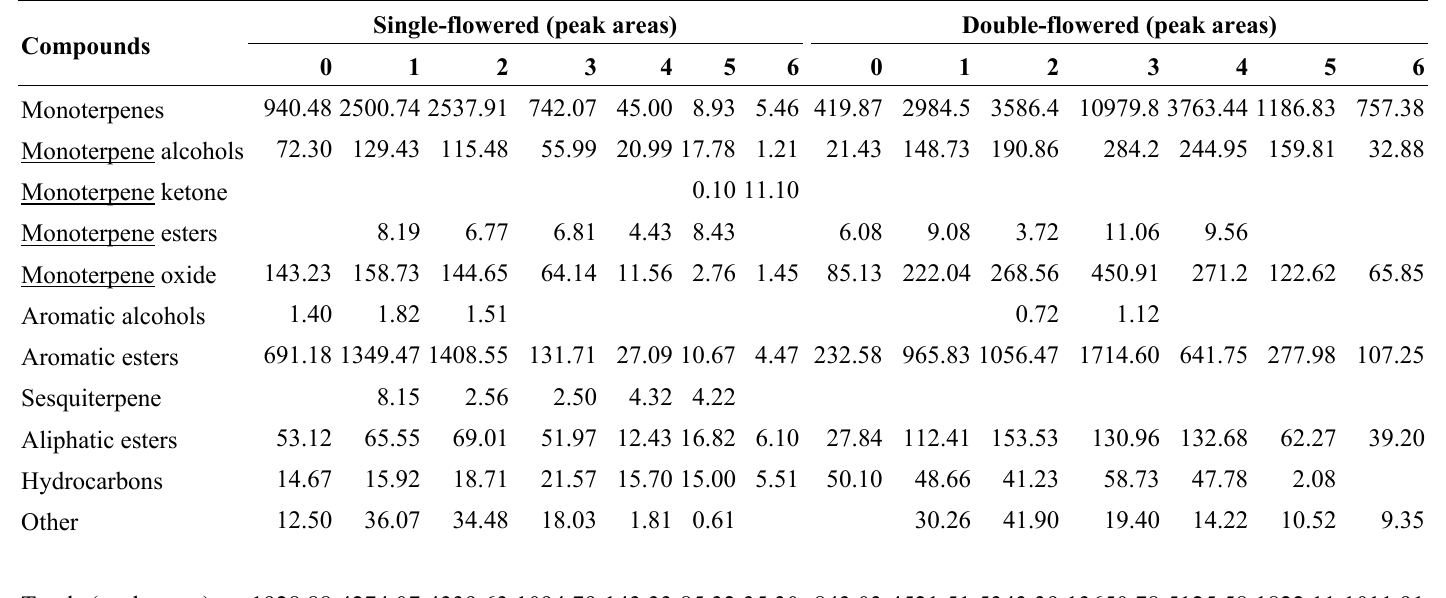
Table 4. Peak areas of chemical groups of volatile compounds on vase life of Narcissus tazetta var. chinensis Roem. Single-flowered (peak areas) Double-flowered (peak Compounds